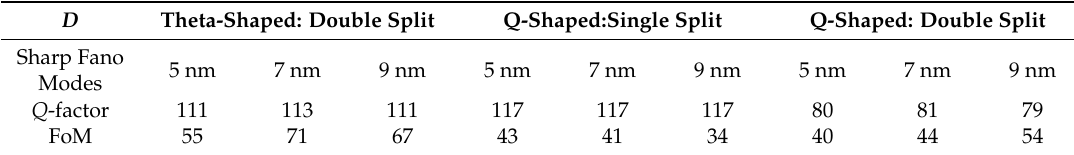
Table 4. Q -factor and FoM values around Fano